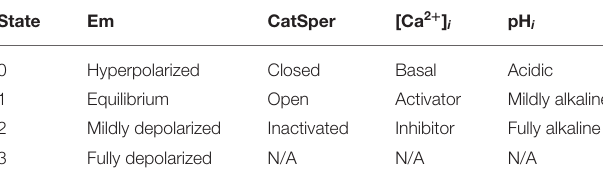
TABLE 1 | States and interpretation of the non-binary